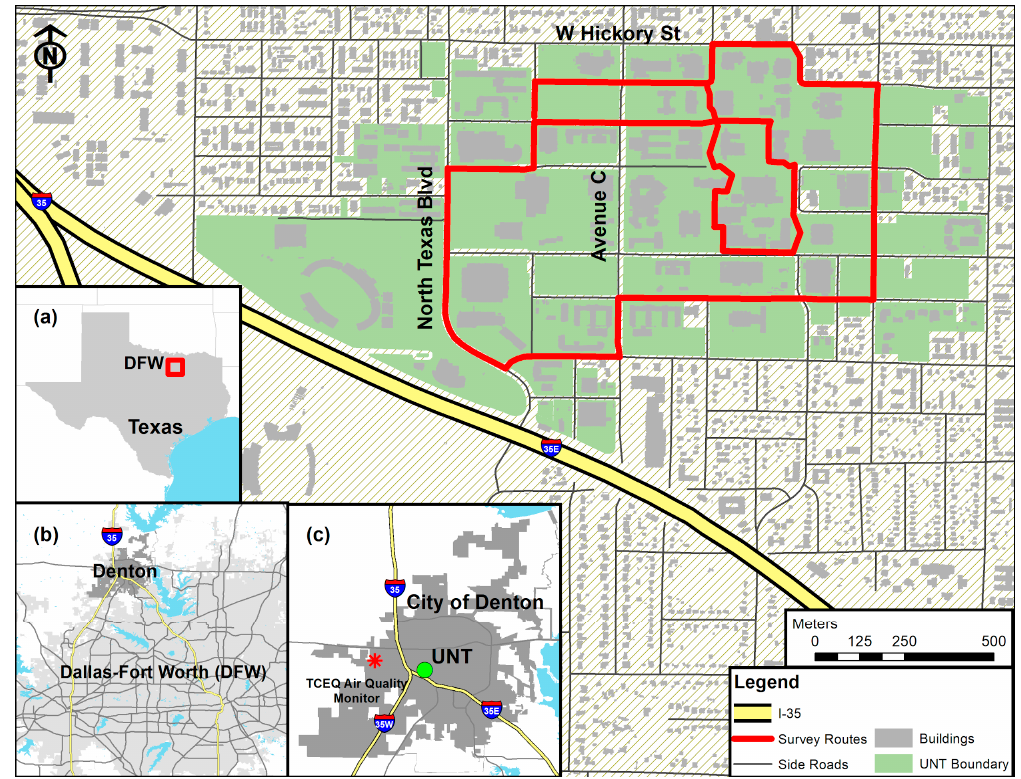
Figure 1. The survey route map. Three inserts separately display: ( a ) location of the Dallas–Fort Worth Metroplex (DFW) in the State of Texas, United States; ( b ) location of the city of Denton in DFW; ( c ) location of University of North Texas (UNT) and the Texas Commission on Environmental Quality (TCEQ) Air Quality Monitor in the City of Denton.